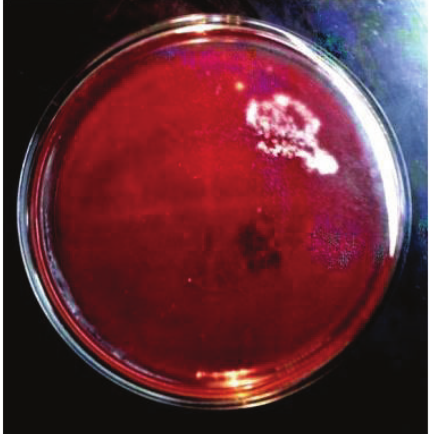
Figure 4: Dry, raised, chalky white colonies of Nocardia on blood agar.